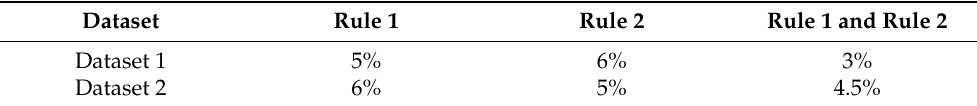
Table 4. The percentage of rejected 20-s windows on both datasets, according to Rule 1, Rule 2, and both rules combined.